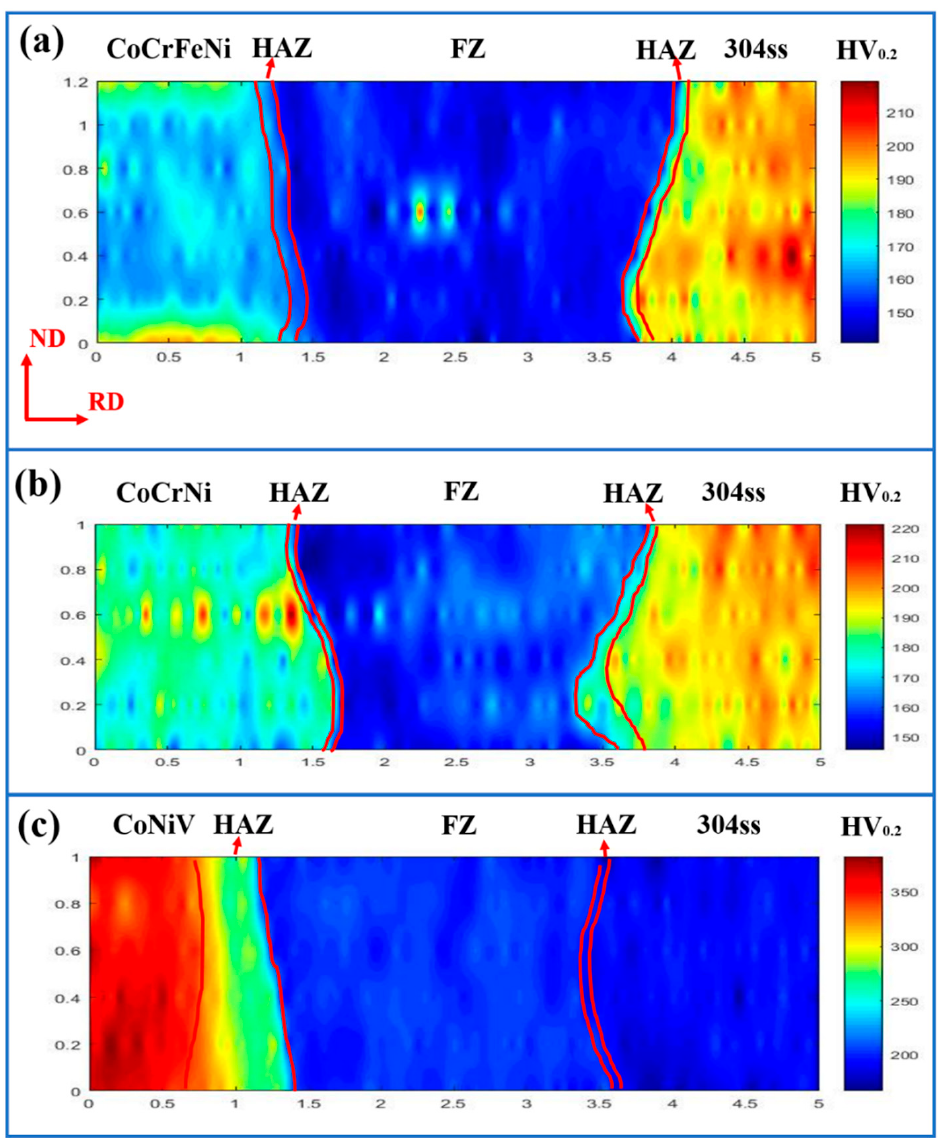
Figure 6. Microhardness distribution of welded joints. ( a ) CoCrFeNi/304ss welded joint; ( b ) CoCrNi/304ss welded joint; ( c ) CoNiV/304ss welded joint.